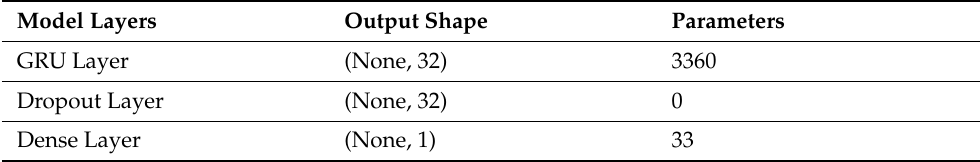
Table 4. Analysis of the architecture of the applied GRU model.